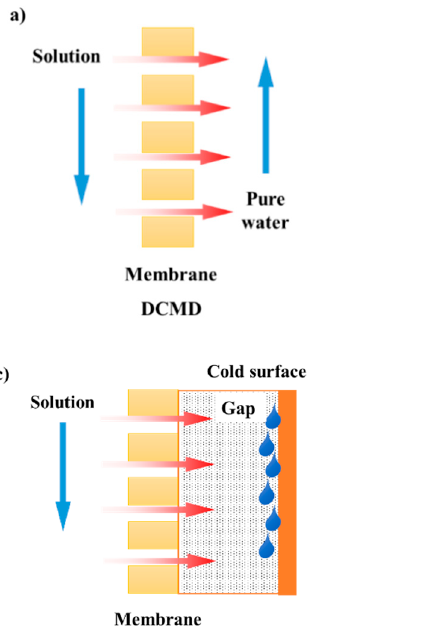
Figure 6. Principle of membrane distillation (MD) process.